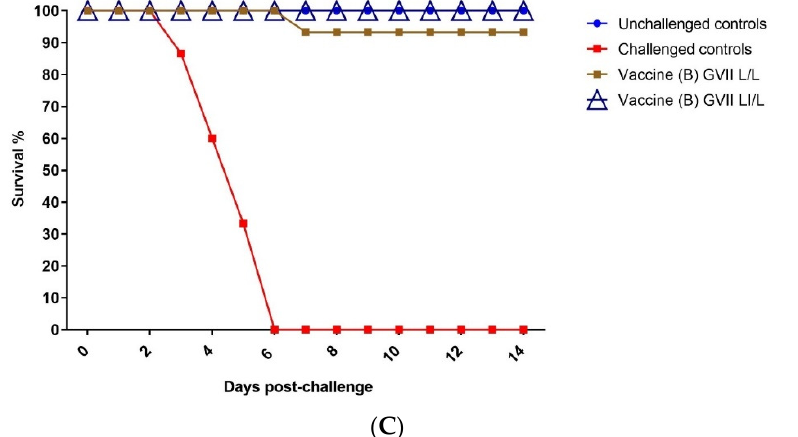
Figure 1. Survival of vaccinated groups post challenge with virulent genotype VII.1.1. Newcastle Disease Virus. ( A ) GII LaSota vaccinated group. ( B ) Vaccine (A) GVII vaccinated group. ( C ) Vaccine (B) GVII vaccinated group. Abbreviations; GII: genotype II-based vaccine, GVII: genotype VII.1.1.-based vaccine, L/L: live vaccine at 7 and 21 days, LI/L: live and inactivated at 7 days, then live vaccine at 21 days.